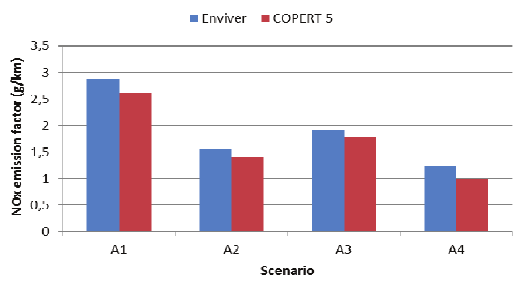
Fig.13. Comparison of Enviver and COPERT 5 emission